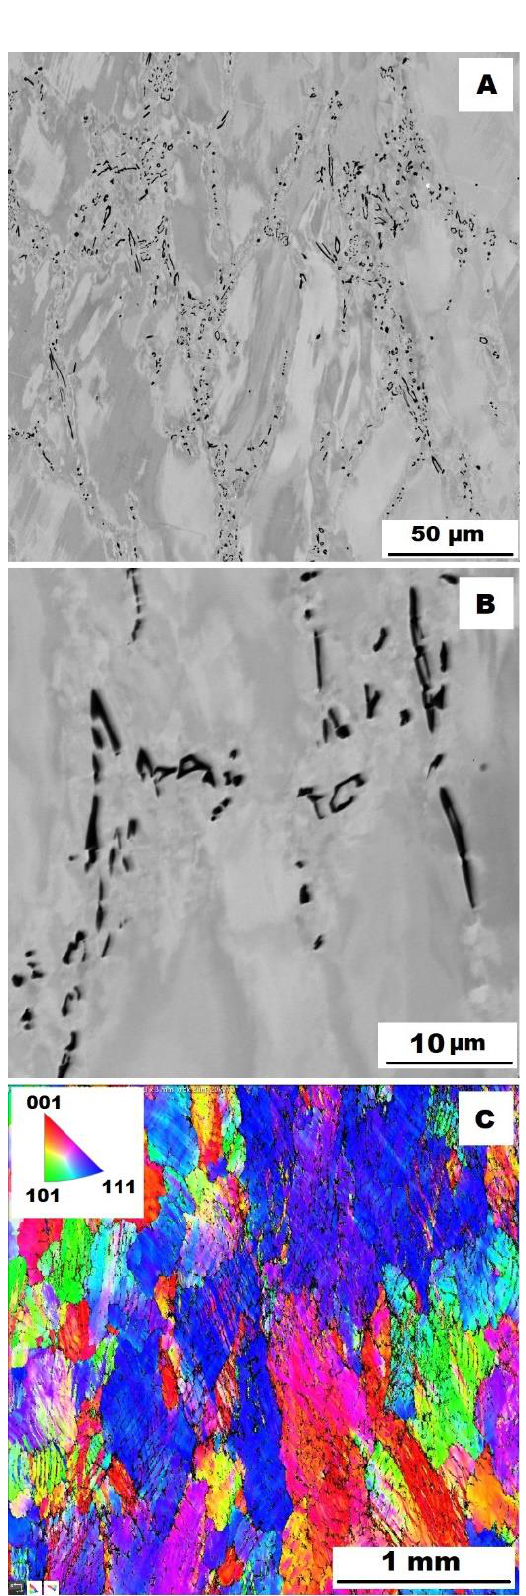
Figure 16. The structure of Fe–28Al–5Si–2Ti–1B alloy in the as-cast state after compression test at 600 °C. ( A ) Overview of the structure-10 kV, BSE. ( B ) Detail of the structure-10 kV, BSE. ( C ) EBSD map of grains-area 3 × 3 mm, step size 2 µm, 20 kV.